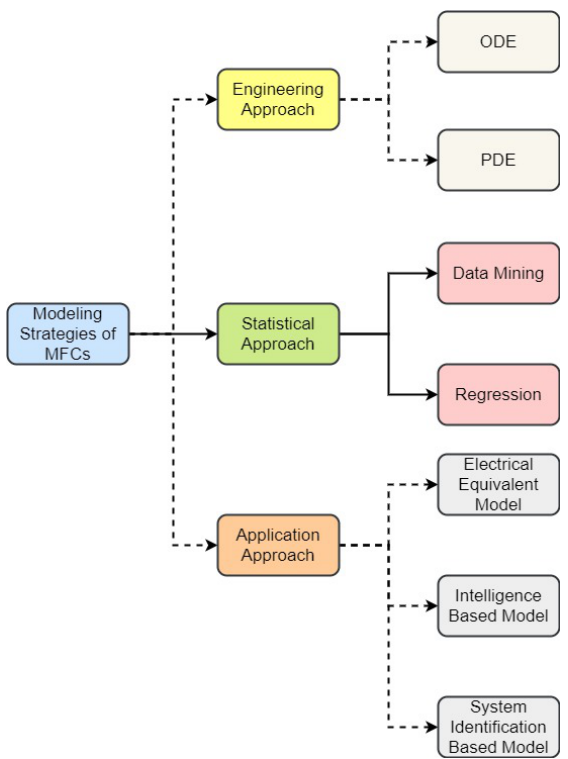
Figure 2. Mathematical modeling approaches. Table 1. Modeling categorization of Microbial Fuel